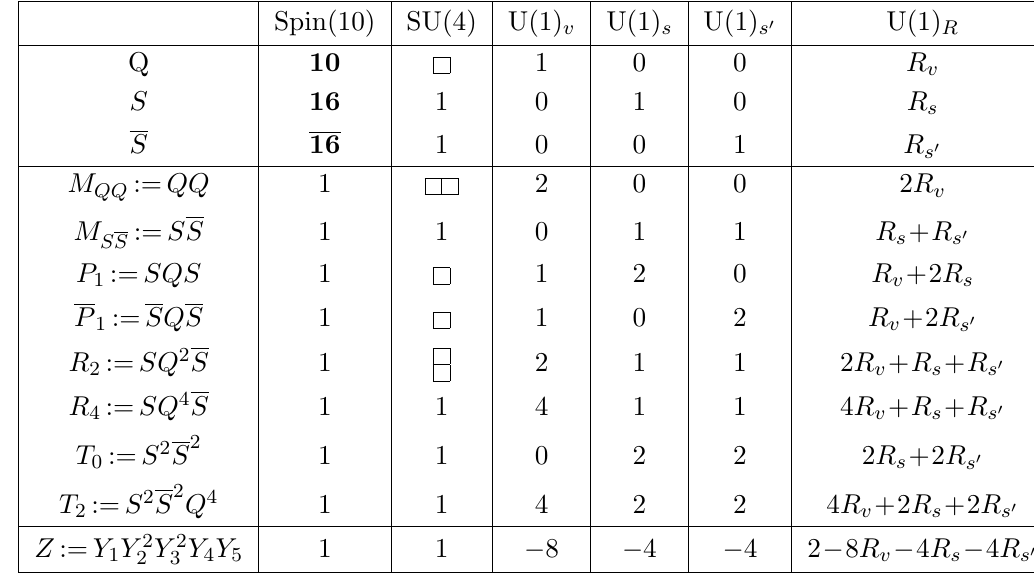
Table 12 . 3d N = 2 Spin(10) theory with ( N v ; N s ; N s 0 ) = (4 ; 1 ;